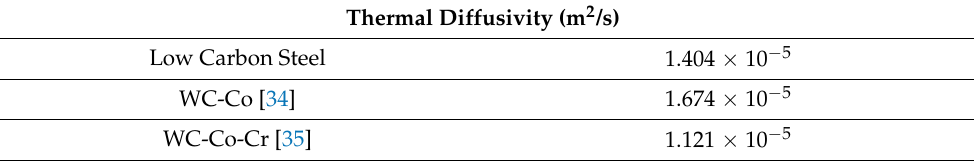
Table 7. Thermal diffusivity of: (i) low carbon steel, (ii) WC-Co and WC-Co-Cr HP-CS investigated coatings. Thermal Diffusivity (m 2